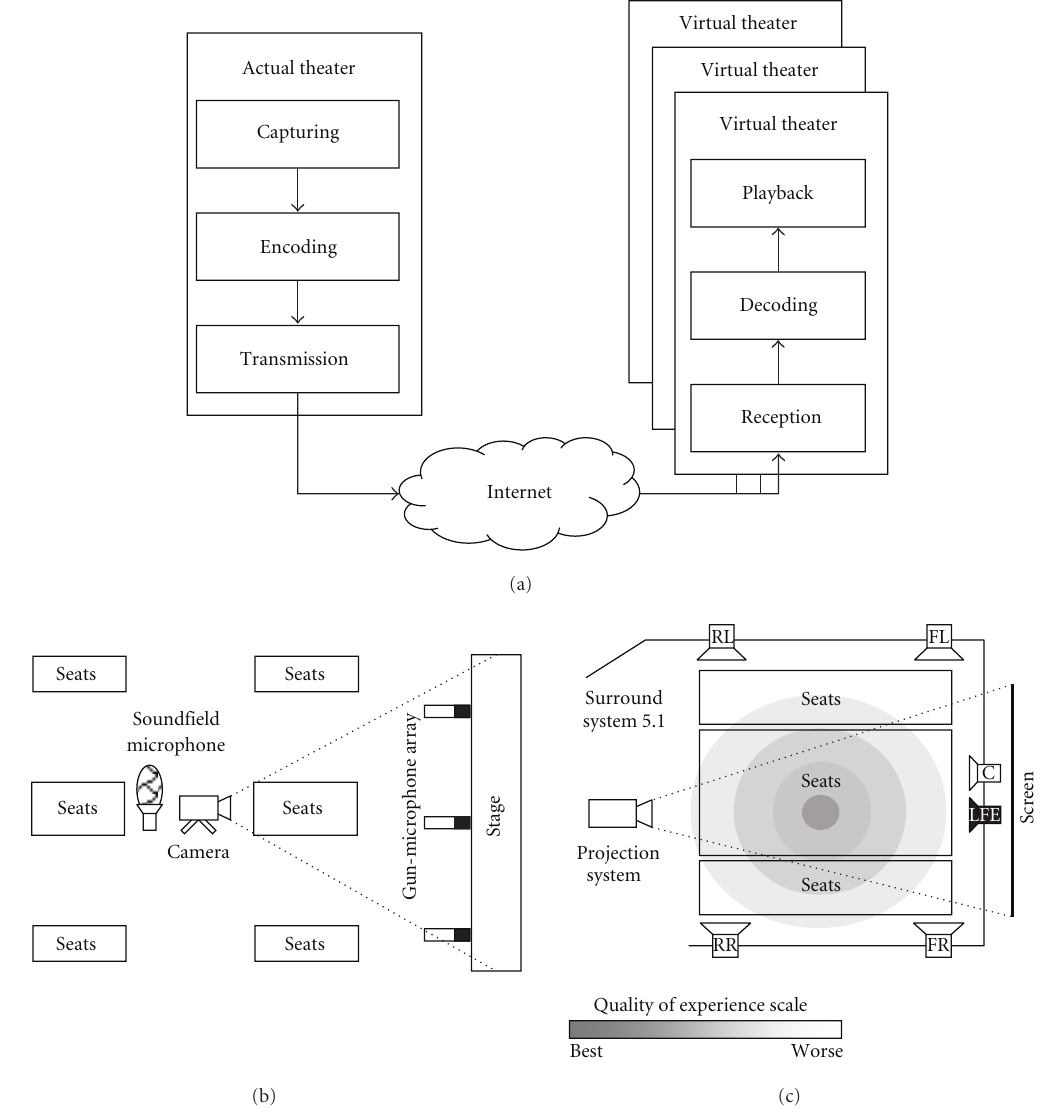
Figure 1: Configuration system setup: (a) architecture overview, (b) actual venue capture setup (transmission site), (c) indicative virtual hall configuration (reproduction